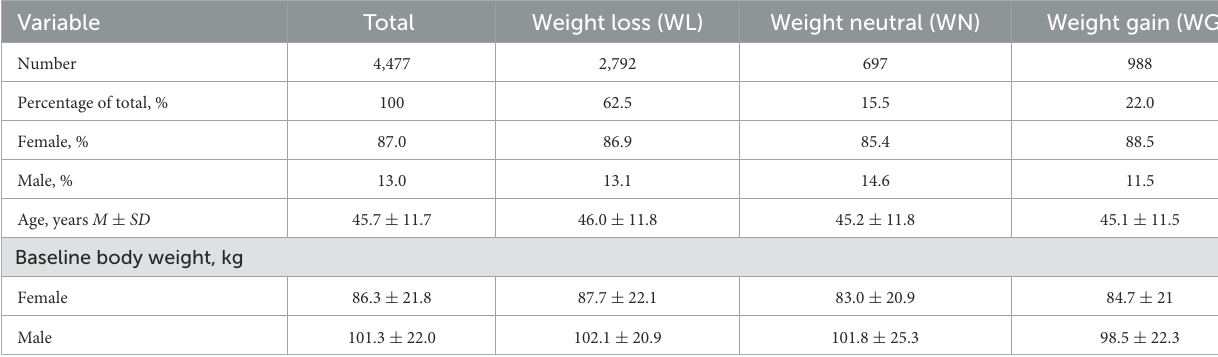
TABLE 1 Baseline demographic characteristics of participants by weight loss